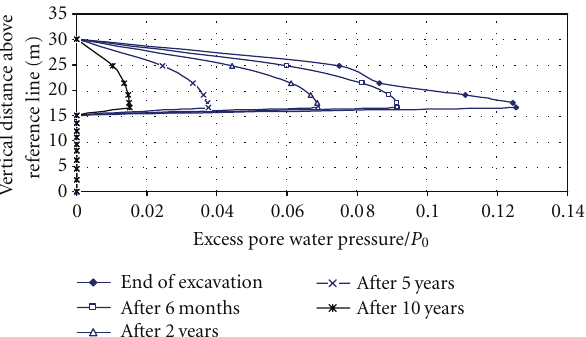
Figure 26: Variation of excess pore water pressure with time along section A-A using MCC soil model.